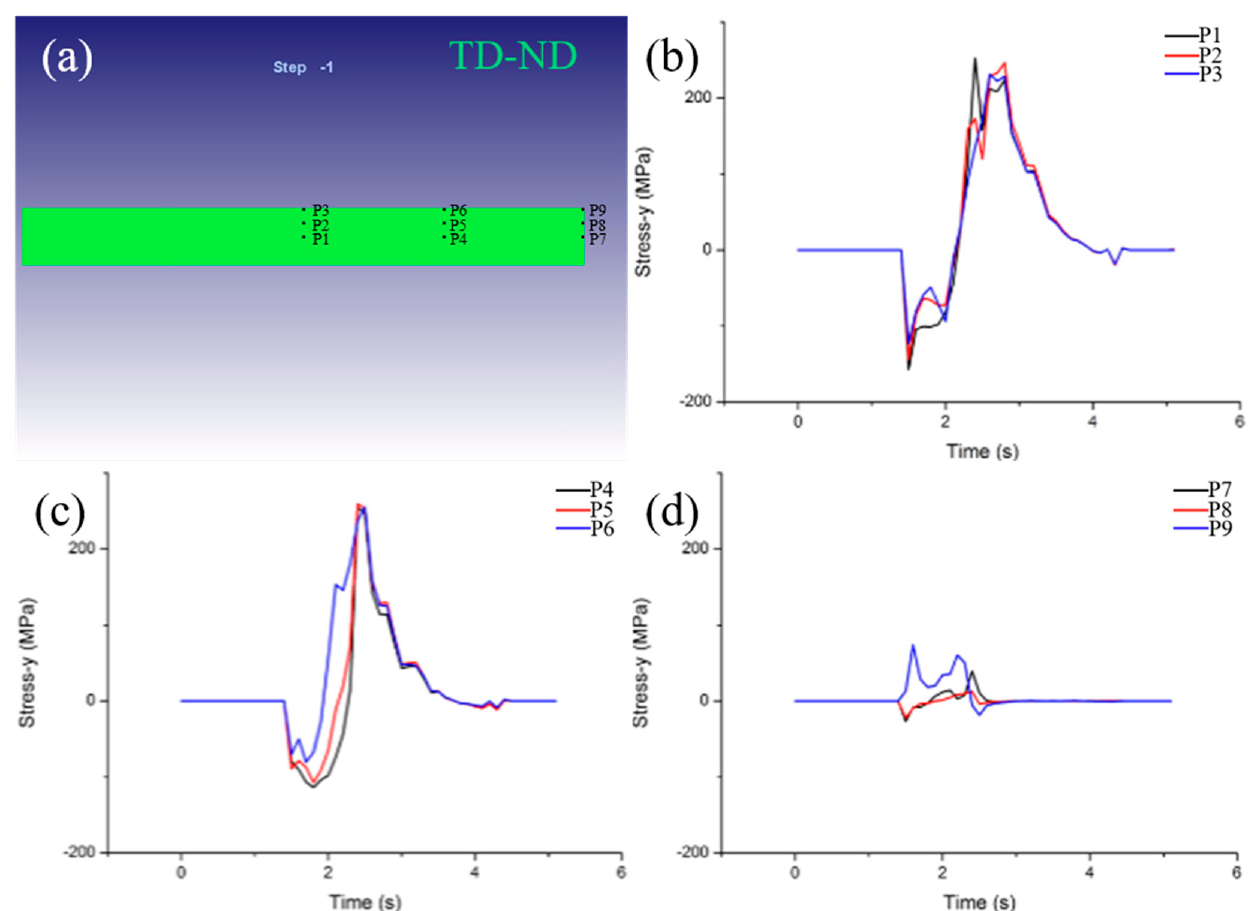
Figure 9. Distribution of characteristic points on TD − ND plane ( a ), the additive stress distribution along TD direction at set point on TD − ND plane at 1400 °C and 20% reduction ( b – d ). Based on the results in Figure 9, the central characteristic points of the TD − ND plane thickness were further selected to simulate and analyze the variation in the additive stress along the TD direction, and these feature points are located at the 11 equal points from the center of the ND − TD plane to the edge as shown in Figure 10a. The additive tensile stress distribution at different rolling temperatures were carried out, as shown in Figure 10b–e. When the rolling temperature is 1300 ◦ C, the maximum tensile stress is 317 MPa. At 1400 ◦ C, the maximum tensile stress is 319 MPa. While the rolling temperature rises to 1500 and 1600 ◦ C, the maximum tensile stress is 327 and 303 MPa, respectively. These data are the stress thresholds for forming longitudinal cracks at corresponding rolling temperatures. If the yield strength of the rolled sample itself exceeds the threshold of longitudinal crack formation, longitudinal crack will not occur in the rolled sample, otherwise, longitudinal crack will be formed. Additionally, the maximum tensile stress of ND − TD plane is basically unchanged at the set temperature range (1300–1600 ◦ C), which further indicates that rolling temperature has little effect on longitudinal cracking. Moreover, it is worth noting that all the